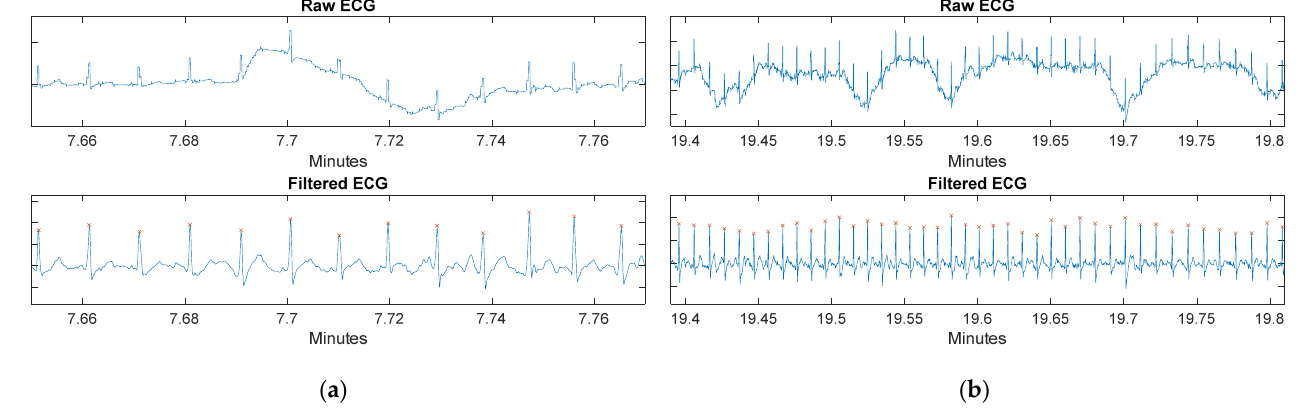
Figure 15. ( a ) Removal of a motion artifact while the subject was combing their hair. ( b ) Elimination of motion artifacts while the subject is walking fast.